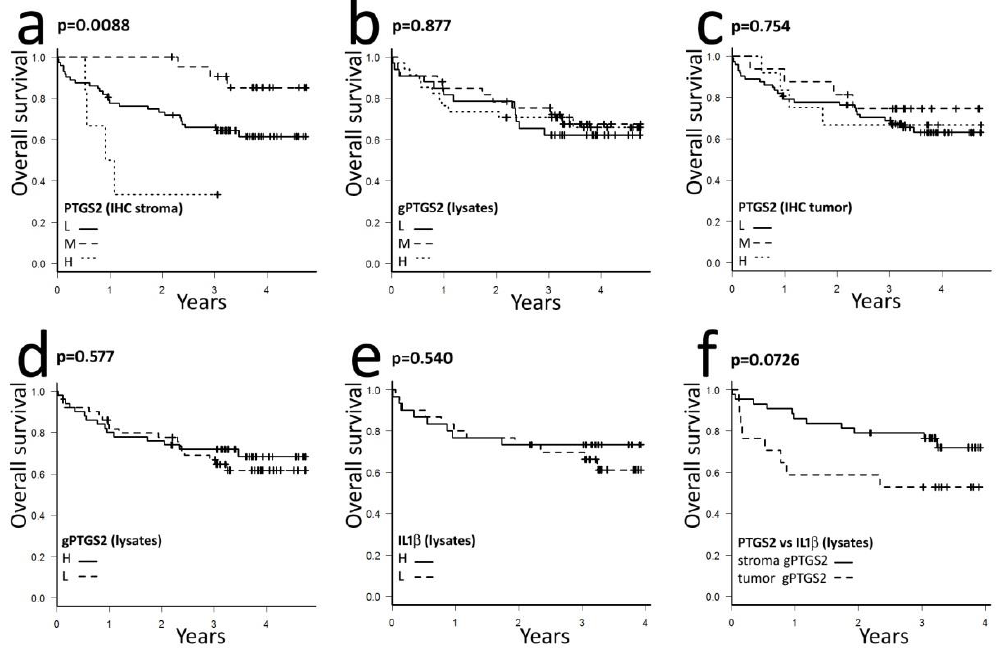
Figure 7. E ff ects of PTGS2 localization on patients overall survival: ( a ) Kaplan–Meier analysis of patients’ overall survival according to PTGS2 levels quantified by IHC in stromal cells. L = low, M = medium, or H = high PTGS2 expression; ( b ) Kaplan–Meier analysis of patients’ overall survival according to gPTGS2 levels quantified in tissue lysates by WB. L = low, M = medium, or H = high gPTGS2 expression; ( c ) Kaplan–Meier analysis of patients overall survival according to PTGS2 levels quantified by IHC in tumor epithelial cells. L = low, M = medium, or H = high PTGS2 expression: ( d–e ) gPTGS2 and IL1 β levels detected in tissue lysates by WB were dichotomized (low vs. high) using the median value of data as a threshold. Kaplan–Meier analysis of patients’ overall survival against low or high gPTGS2 (d) or IL1 β (e) levels was not a ff ected by this dichotomization; ( f ) Dichotomization shown in panels d–e was used to separate tumors into two new classes: the first with a directly proportional regulation of gPTGS2 and IL1 β (gPTGS2 low IL β low + gPTGS2 high IL β high = stroma gPTGS2 enriched, continuous line), the other with an independent regulation of these markers (gPTGS2 low IL β high + gPTGS2 high IL β low = tumor gPTGS2 enriched, dashed line). The Kaplan–Meier analysis of patients’ overall survival based on this subdivision is